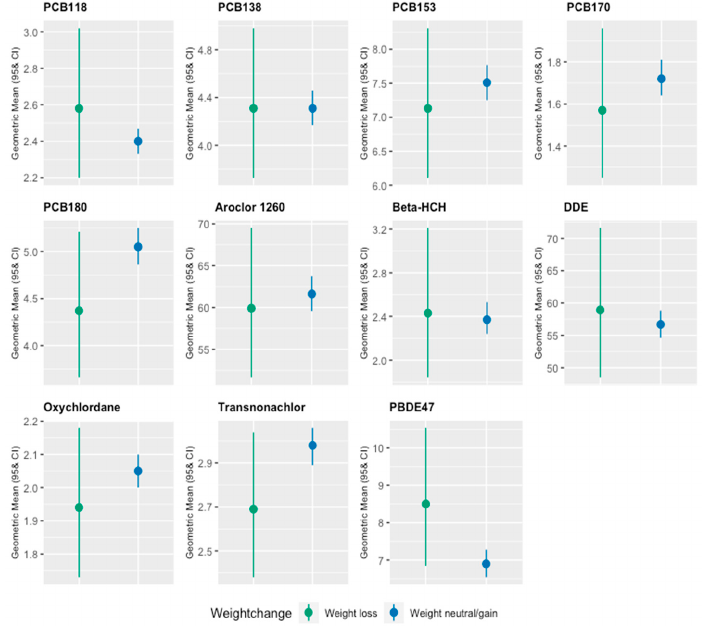
Figure 2. Geometric means and 95% confidence intervals (CI) of eleven POP concentrations by early gestational weight change categories (colors illustrate the weight change categories). N = 1832 pregnant individuals, MIREC Study. Table 4. Unadjusted and adjusted a associations [ β (95%CI)] between first-trimester weight change (BMI) and lipid-adjusted persistent organic pollutants (POPs) concentrations detected in at least 50% of the samples, MIREC Study b